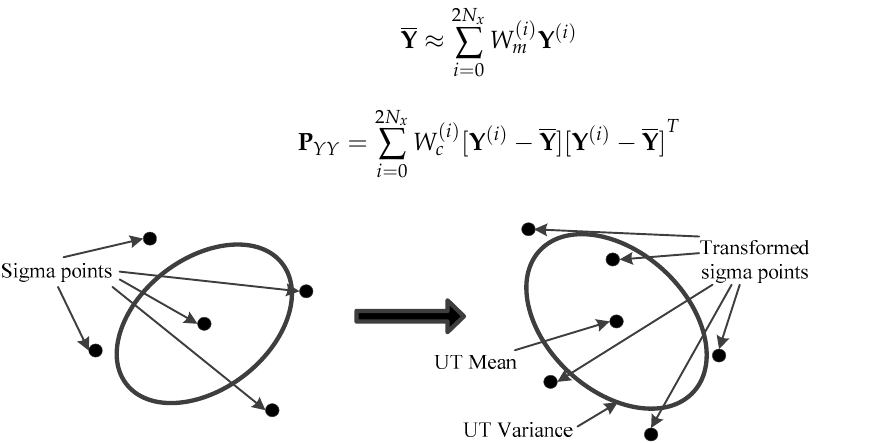
Figure 1. The schematic of unscented transformation.